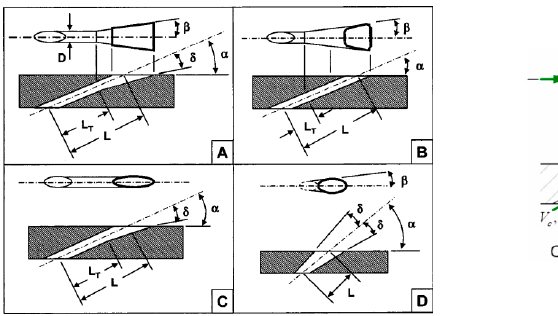
Figure 5. Popular design configurations of film cooling holes [30,31] are schematically illustrated in ( A – D ). More configurations are available in [32].